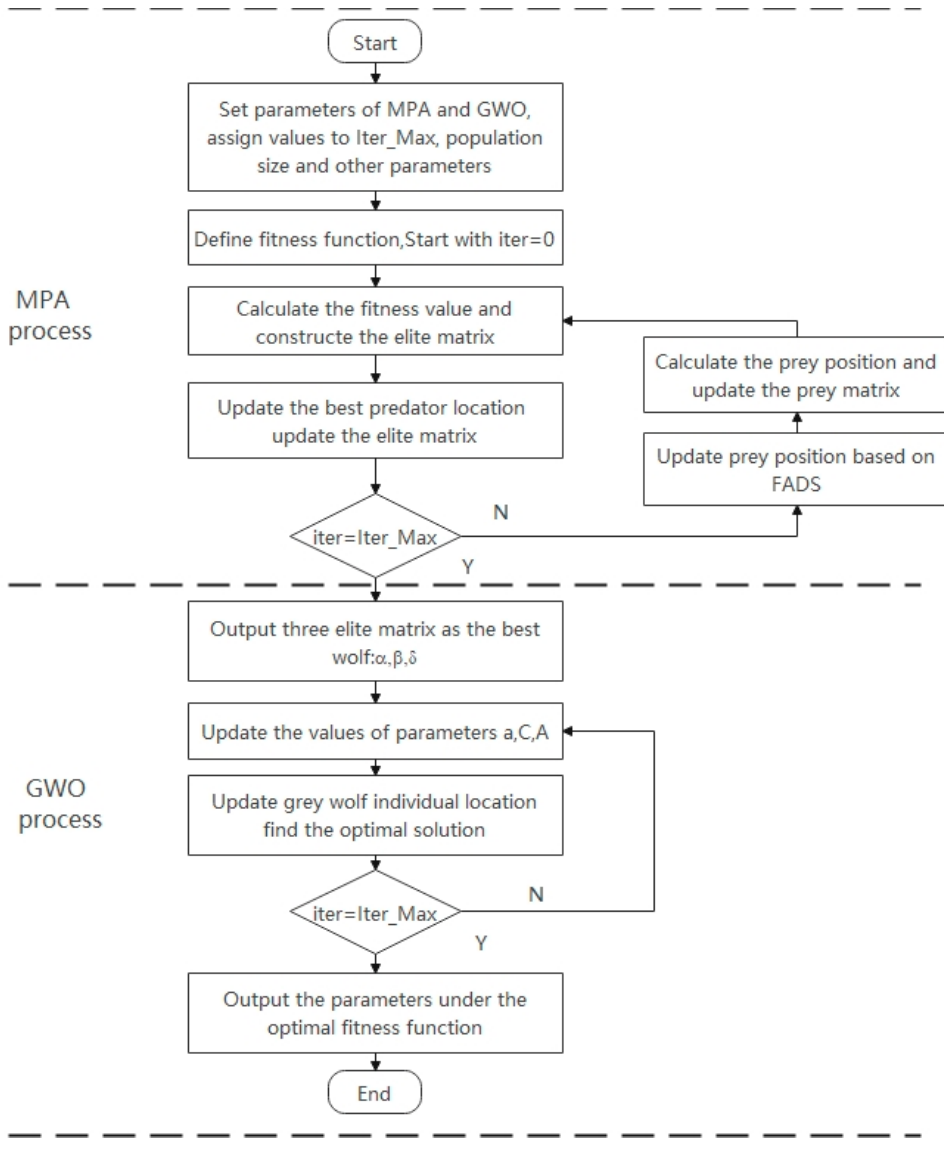
Figure 2. MPA improvement GWO flow chart.